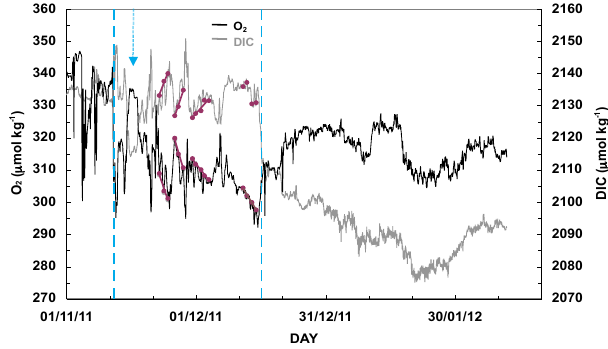
Figure 7. Distribution of O 2 in µmolkg − 1 (black, left vertical axis) and DIC in µmolkg − 1 (grey, right vertical axis) between 1 Novem- ber 2011 and 12 February 2012. The purple dots and lines indicate the periods when NCP estimates have been made. The cyan dashed lines indicate 12 November and 16 December and the cyan arrow 16 November (see